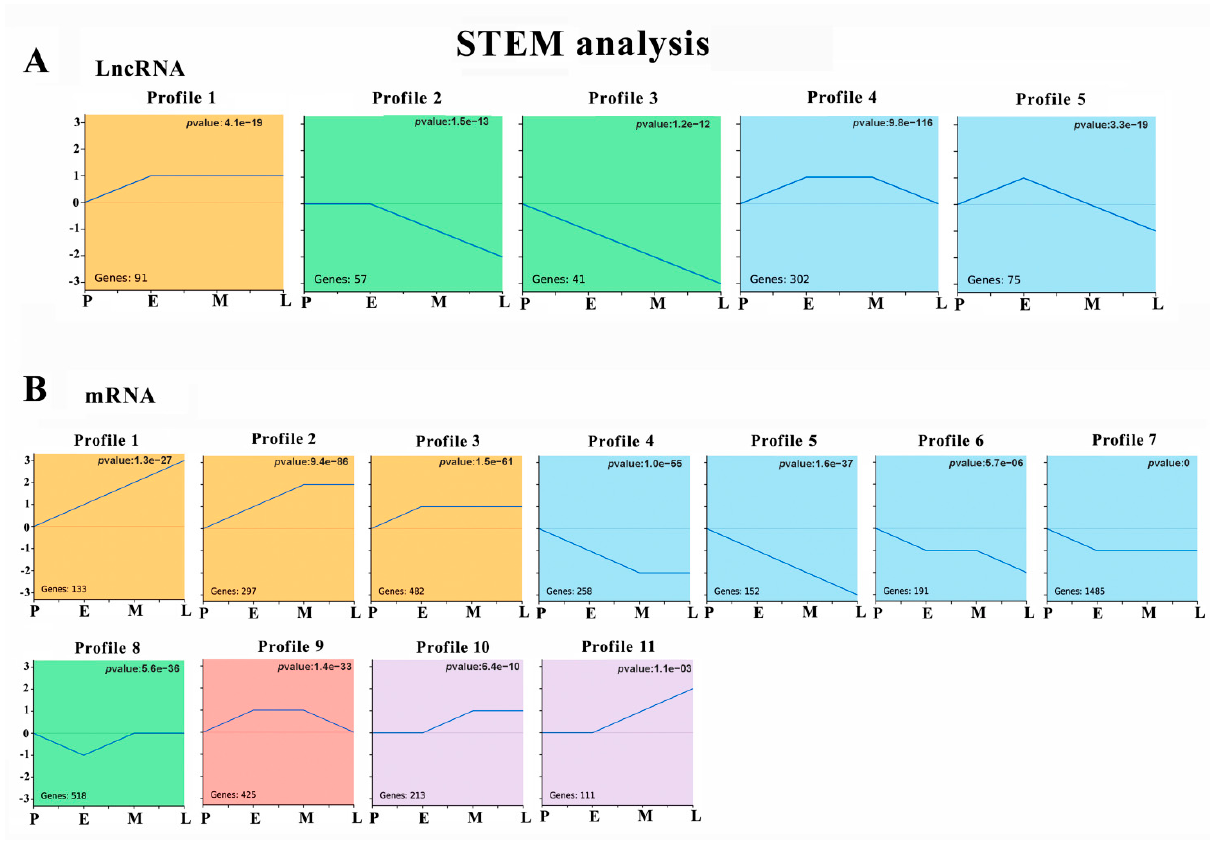
Figure 3. STEM identified the temporal expression profiles of DE lncRNA and DE mRNAs with p < 0.05: ( A ) 5 clustered profiles of temporal expressed DE lncRNA; ( B ) 11 clustered profiles of temporal expressed DE mRNA. The blue lines in the profile boxes depict the gene expression patterns at the four time points. The number on the bottom left represents the number of genes and the number on the top right corner represents the adjusted p -value.